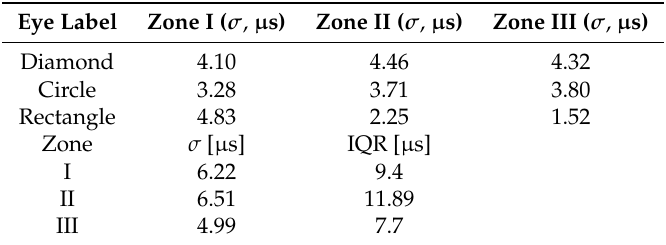
Table 1. Standard deviation σ and interquartile range (IQR) from the data shown in Figure 4.